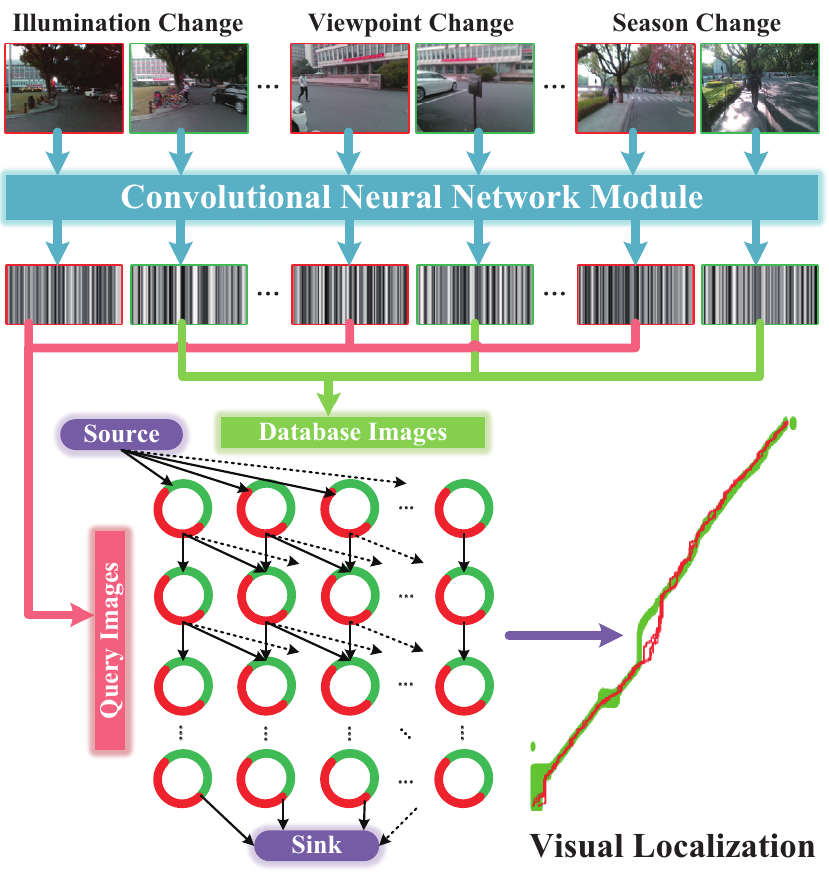
Figure 3. The flow chart of the proposed Visual